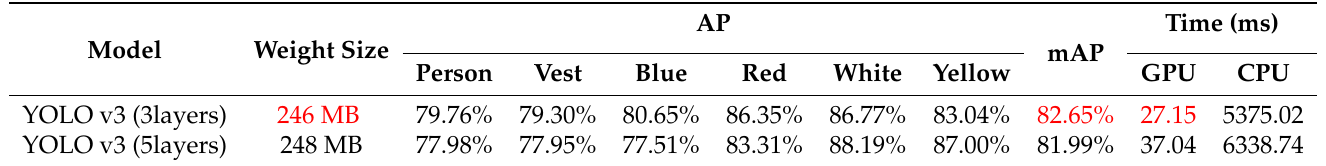
Table 4. Performance of YOLO v3 models.